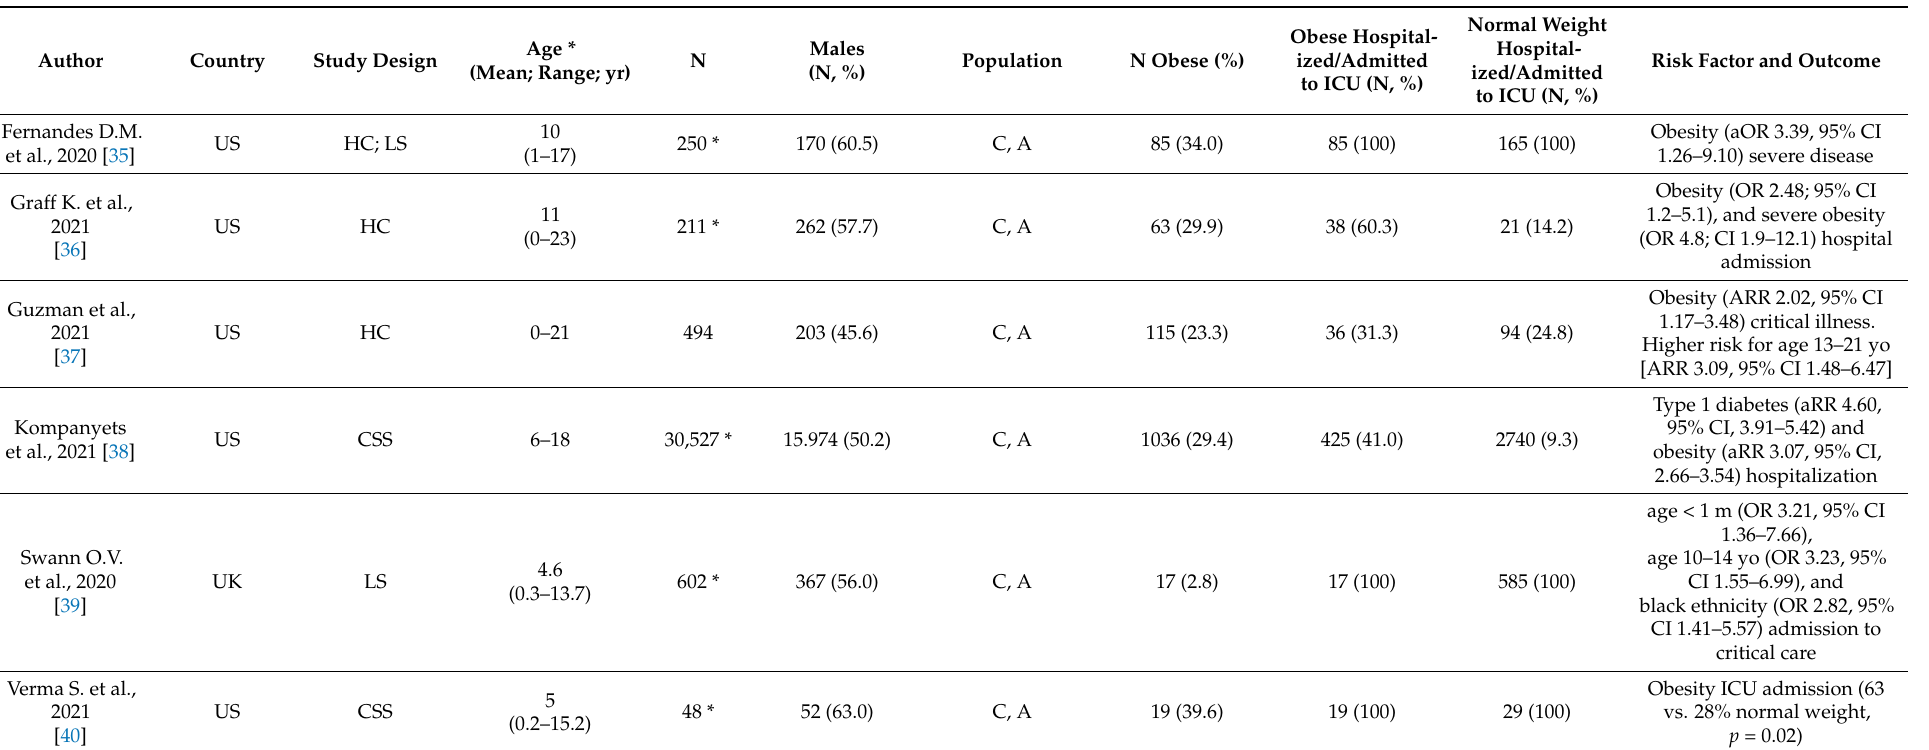
Table 2. Main patient and study features of articles assessing the risk of hospital admission/ICU in obese children and adolescents included in literature review.